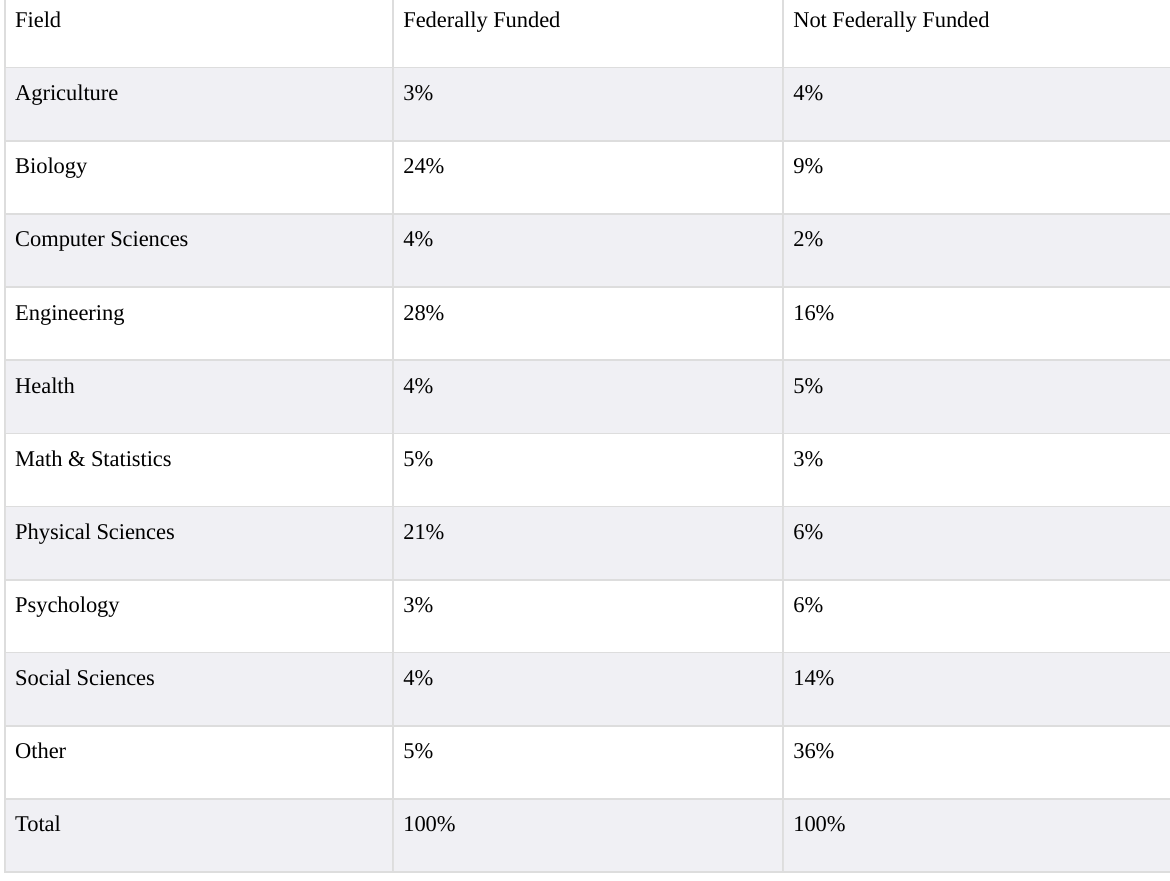
Table 2. Earned doctorates in STEM fields are more likely to have received federal